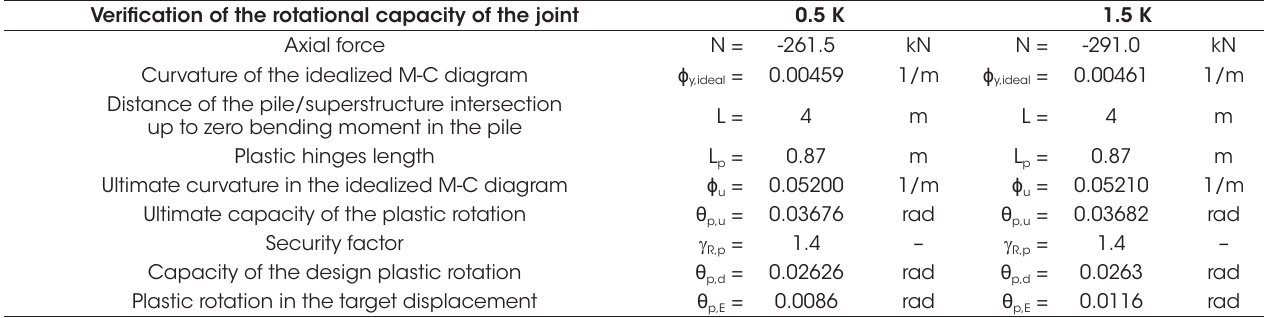
Verification of the rotational capacity of the joint in according to Eurocode [6]